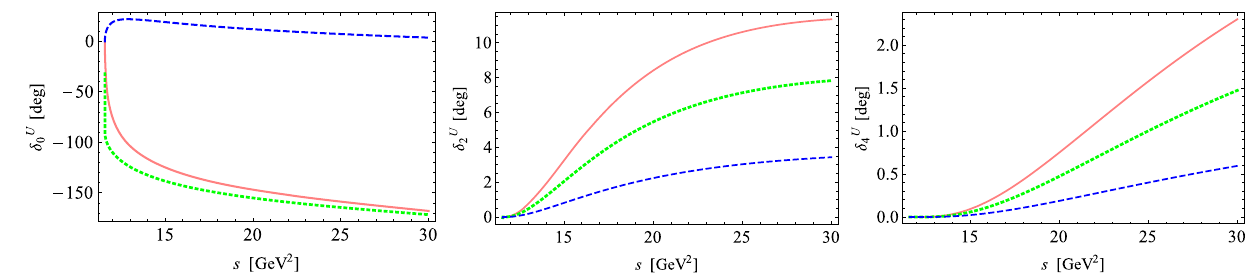
Fig. 6 The phase shift of the unitarized amplitude for S - (left), D - (center), and G -wave (right) for the values (cid:2) G = 0 . 4GeV (pink, solid), 0 . 5041GeV (green, dot), and 0 . 8GeV (blue, dash). The functions are plotted for values of s only slightly higher than the elastic window